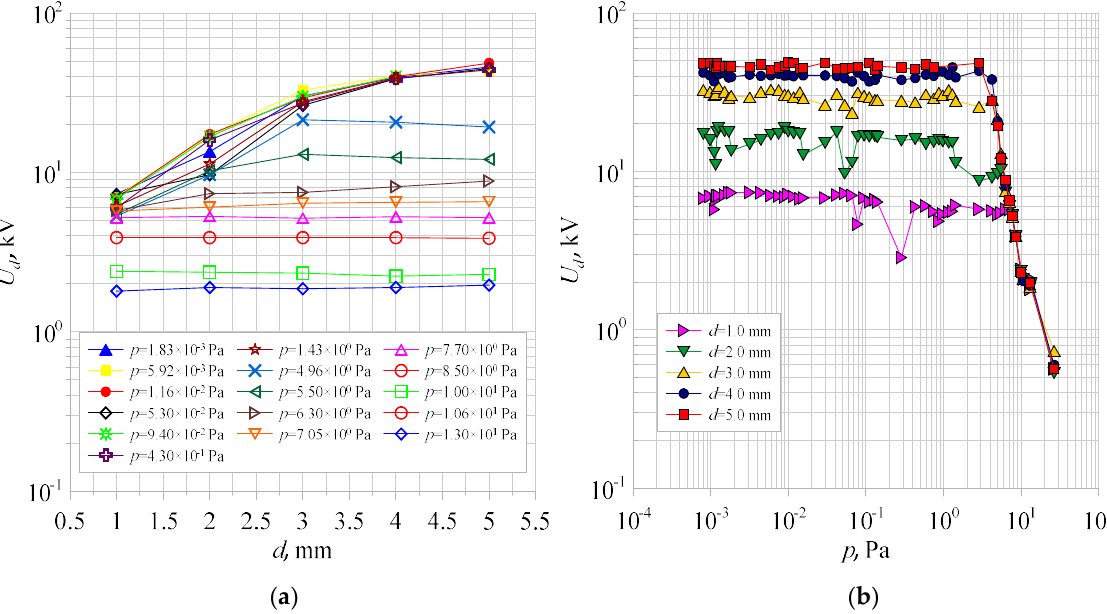
Figure 6. The dependence of the breakdown voltages U d as a function of ( a ) the electrode spacing d for selected pressures and ( b ) the pressure p inside the test vacuum interrupter, for residual gases that are pure air.